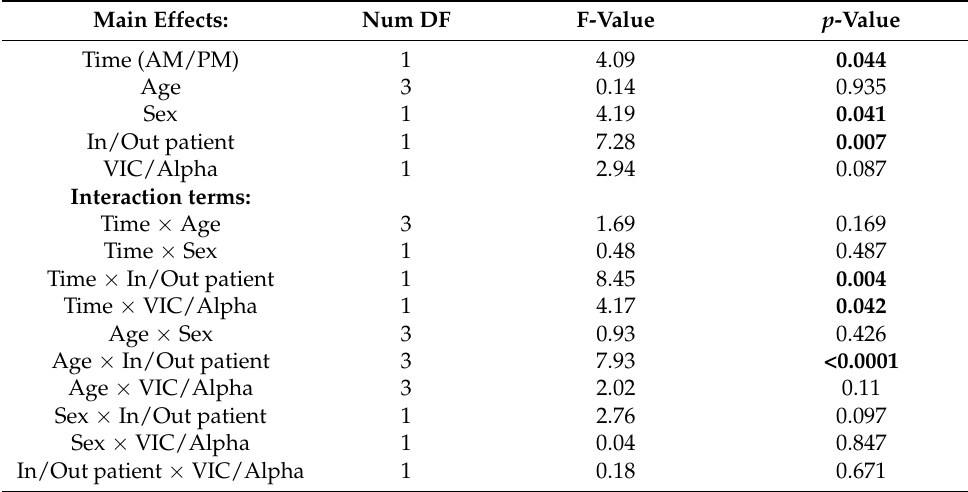
Table 2. Linear mixed-effect modelling results (Type III tests of fixed effects). Main